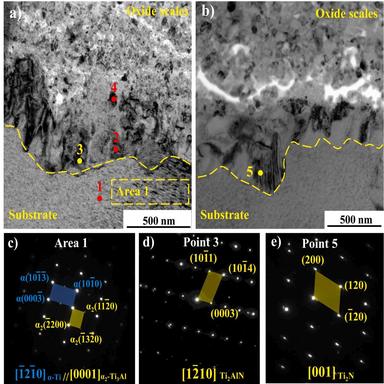
Microstructure and phase composition of the sub-interface area: (a,b) TEM-BF image of the sub-interface area, (c) SAD patterns of the corresponding area in (a), (d) SAD patterns of the "Point 3′′ marked in (a), (e) SAD patterns of the "Point 5′′ marked in (b).